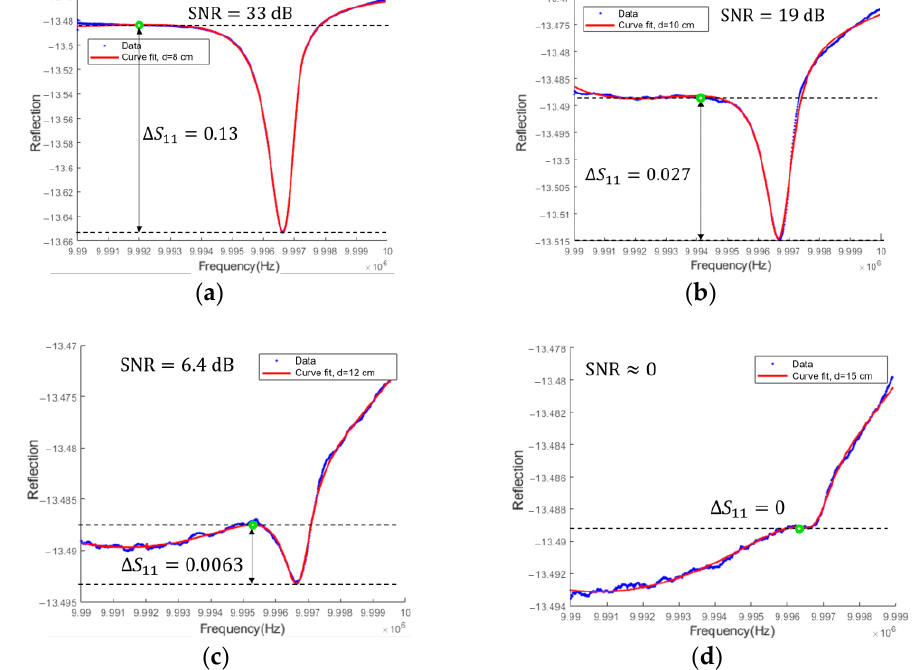
Figure A4. The signal processing for different gaps. Each curve is the average of five repeated measurements. ( a ) d = 8 cm. ( b ) d = 10 cm. ( c ) d = 12 cm. ( d ) d = 15 cm. The magnitude of the signal is 0 because both feature points are absent.